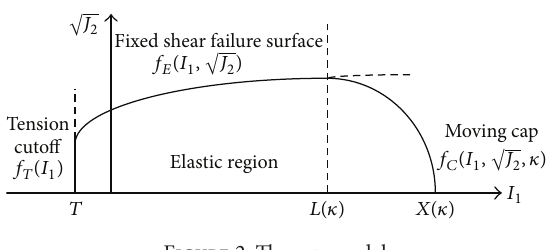
Figure 2: The cap